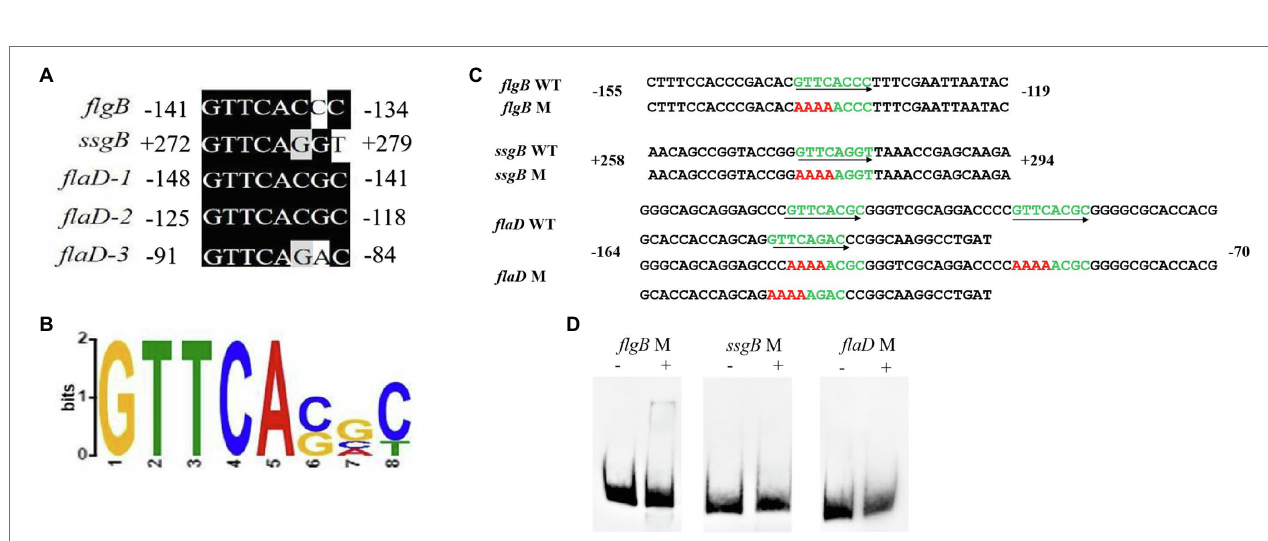
FIGURE 5 | Consensus binding sequence for PhoP in A. pretiosum and mutational analysis of predicted PHO box-like motif in the promoters of flgB , ssgB , and flaD . (A) Alignment of putative PHO boxes box-like motif in the promoters of flgB , ssgB , and flaD . Conserved nucleotides are indicated by a dark background. (B) Consensus binding sequence for PhoP comprising eight nucleotides, based on the alignment in panel (A) . (C) Mutation analyses of putative PHO box-like motif in the promoters of flgB , ssgB , and flaD . Putative PHO box-like motifs are shown in green and mutagenized nucleotides are in red. The orientation of consensus sequences is indicated by arrow. (D) EMSAs with mutant probes. The probes were incubated with no protein ( − ) or 4 μ g protein (+).